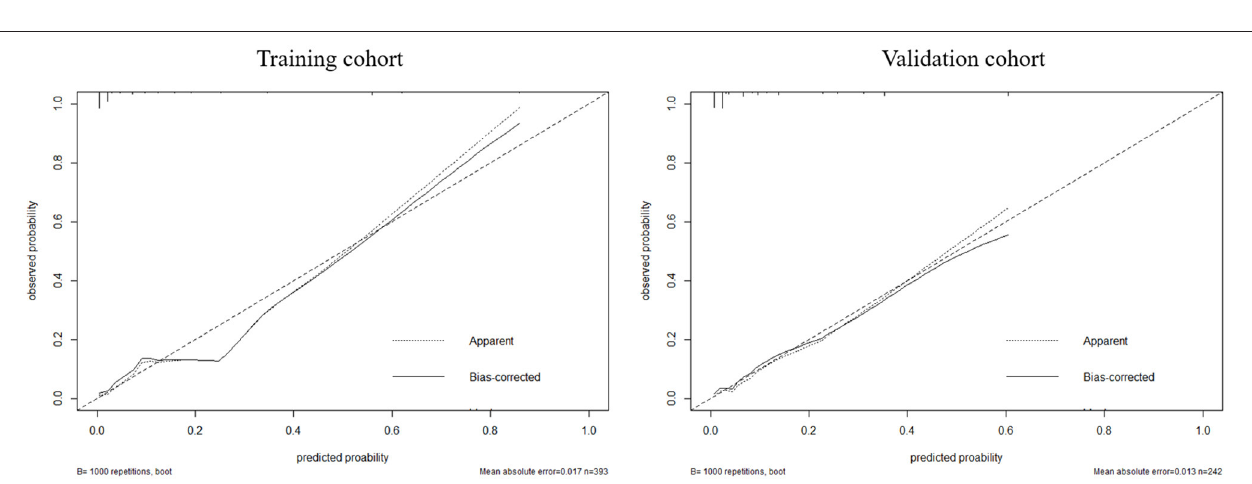
FIGURE 5 | The nomogram for predict the occurrence of postoperative tracheostomy. NLR, neutrophil-to-lymphocyte ratio; WFNS, World Federation of Neurological Surgeons Scale; BNI, Barrow Neurological Institute.